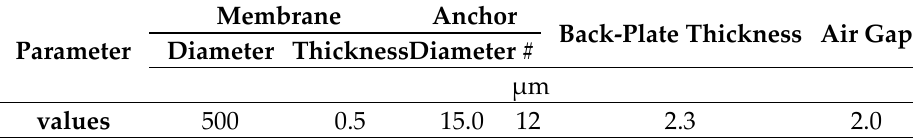
Table 2. Design parameters of the MEMS microphone with dual anchored membrane.